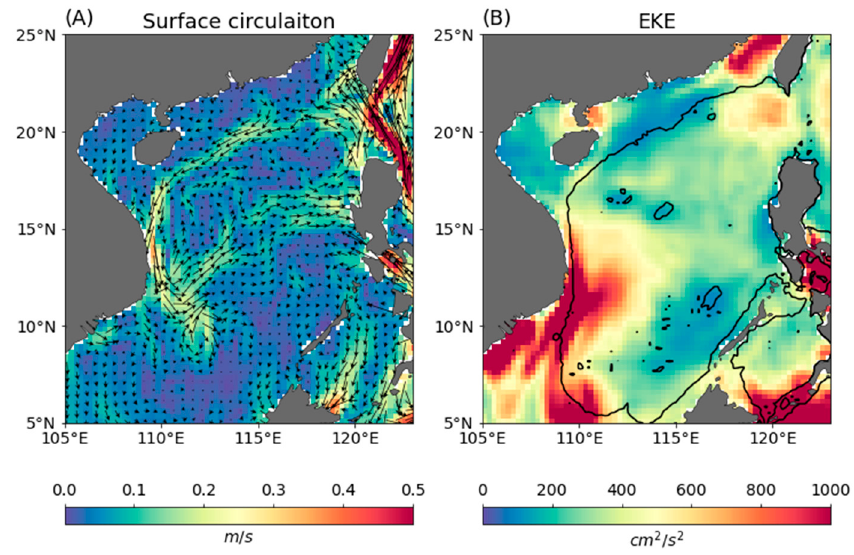
Figure 1. Climatological ( A ) surface geostrophic currents (black vectors) and their speed (colors); ( B ) surface eddy kinetic energy (colors) in the SCS. The black contour in ( B ) indicates the 200 m isobath.